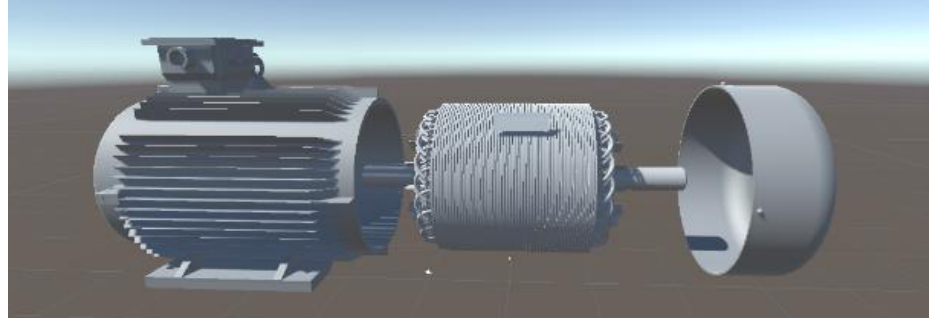
Figure 3. Geometric